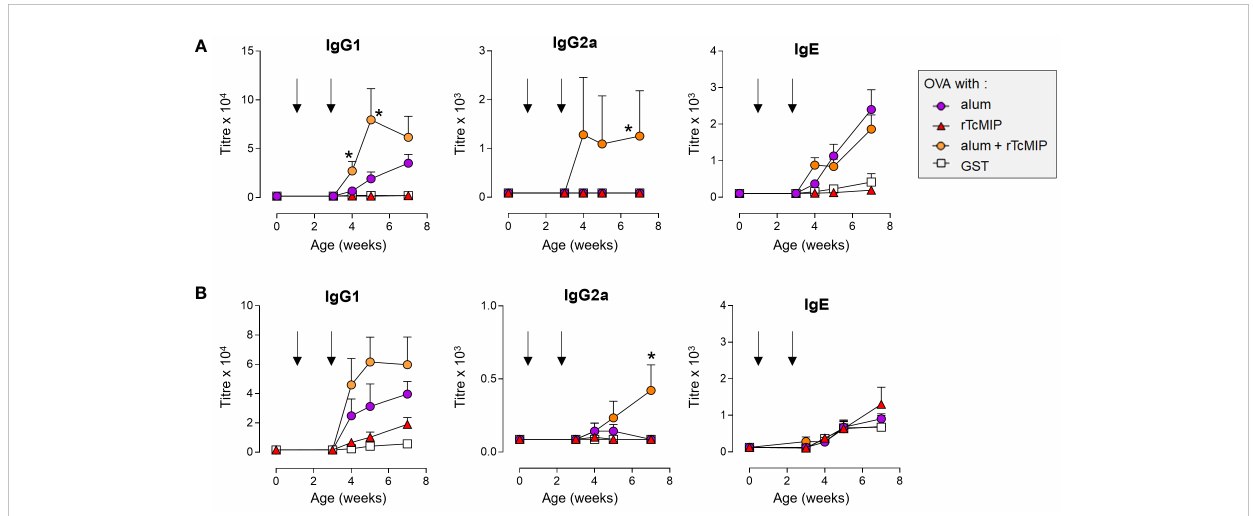
FIGURE 9 Antibody levels in neonatal mice immunized against OVA adjuvanted by rTcMIP. Neonatal Balb/c mice (n = 6/group) were immunized with OVA (2.5 µg/injection) adjuvanted with alum, rTcMIP (10 µg), alum + rTcMIP or alum + GST (5 µg). Mice received intraperitoneal (A) or subcutaneous (B) injections at 7 and 21 days of age (arrows). OVA-speci fi c circulating antibodies were titrated just before the second immunization and 1, 2 and 4 weeks after the second immunization. No Abs were detected in non-immunized mice neither in those receiving OVA, alum or rTcMIP alone (not shown). Antibody titers were determined by ELISA. *P< 0.05 alum + rTcMIP vs. alum (Mann Whitney test). Statistically signi fi cant results between other mouse groups are not